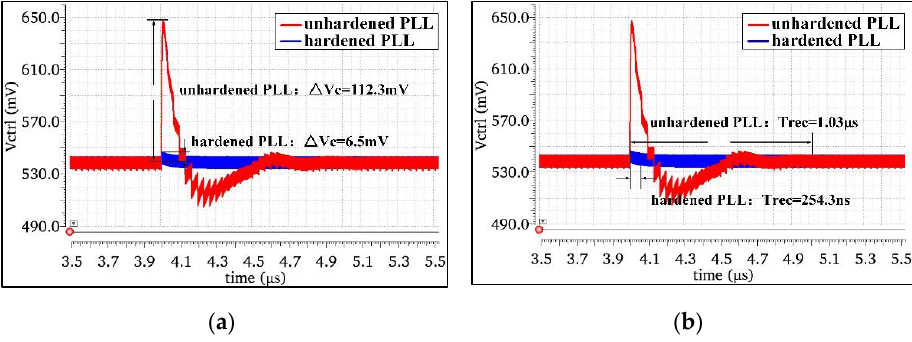
Figure 11. ( a ) Simulation results of the voltage disturbance. ( a ) Simulation results of the recovery time.